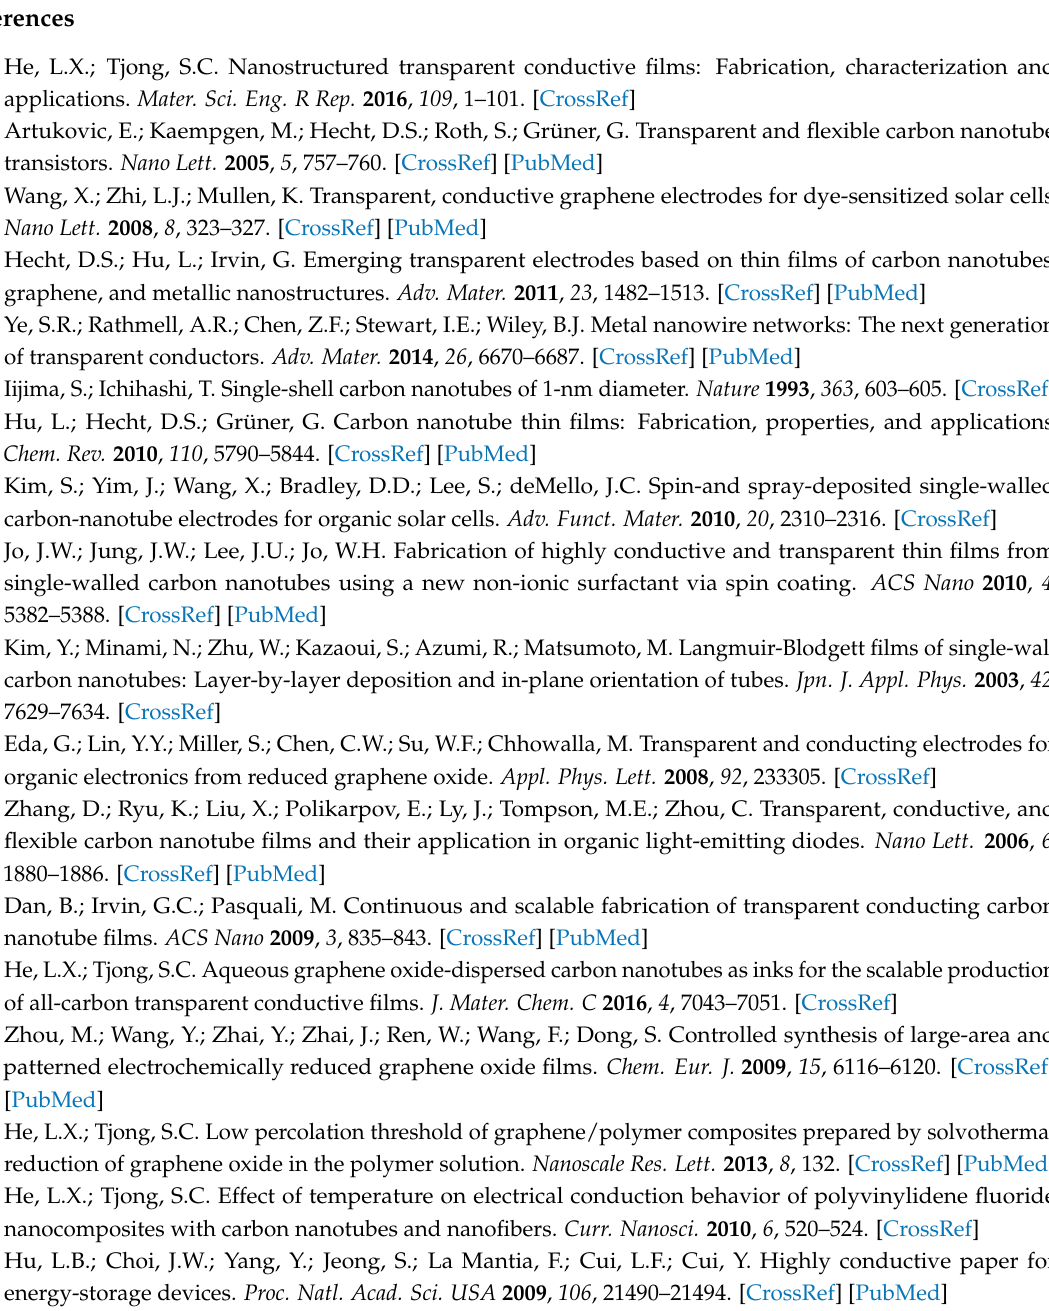
30:1. Figure S7: (A) Effect of nitric acid doping on electro-optical performance of 86% transparent rGO-SWNT films. (B) Stability of nitric acid-doped 86% transparent rGO-SWNT film. Figure S8: (A) Photograph of a GO-SWNT film of ~4 × 5 inch 2 prepared from GO-SWNT ink by rod coating. (B) and (C) Low magnification SEM micrographs of location I and II showing morphological uniformity of the film. The white dots are catalyst